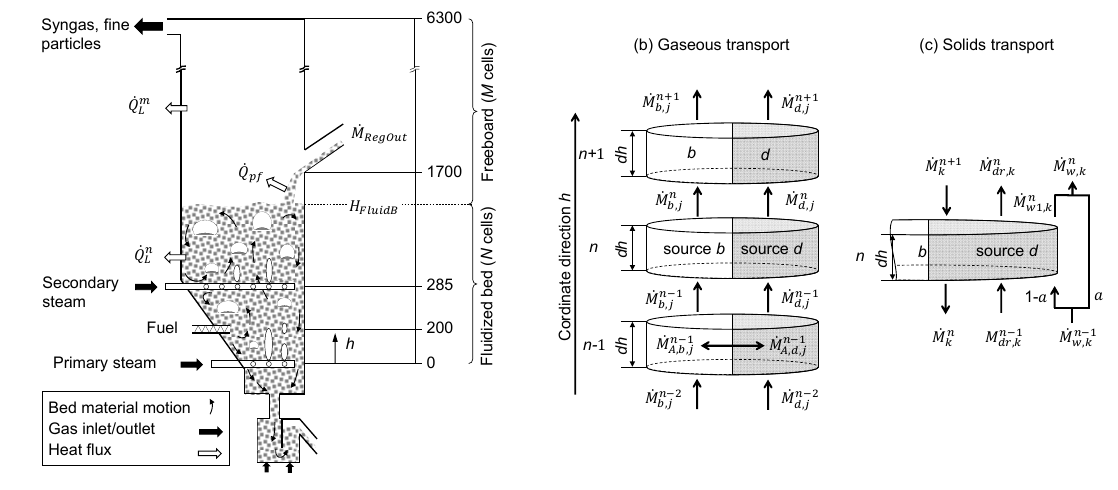
Figure 4. ( a ) Scheme of bubbling fluidized bed gasifier with levels (in mm) of inlet/outlet flows; Cell model of the fluidized bed, ( b ) Gaseous flows, and ( c ) Solid flows.